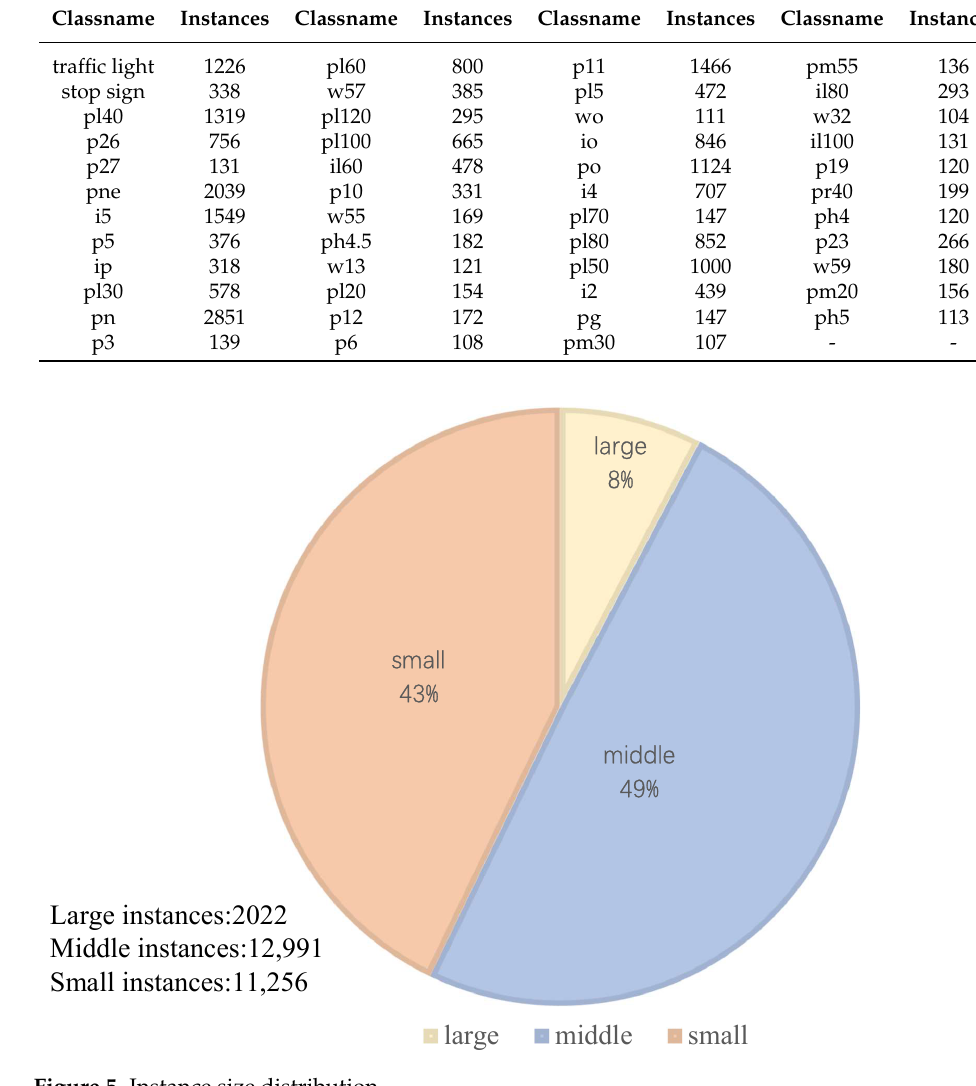
Figure 5. Instance size